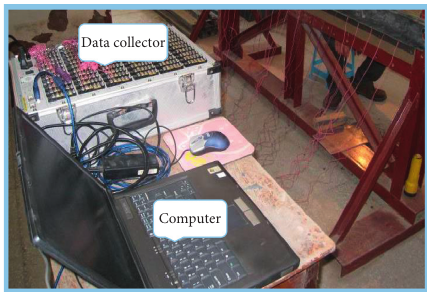
Figure 6: Data acquisition device.